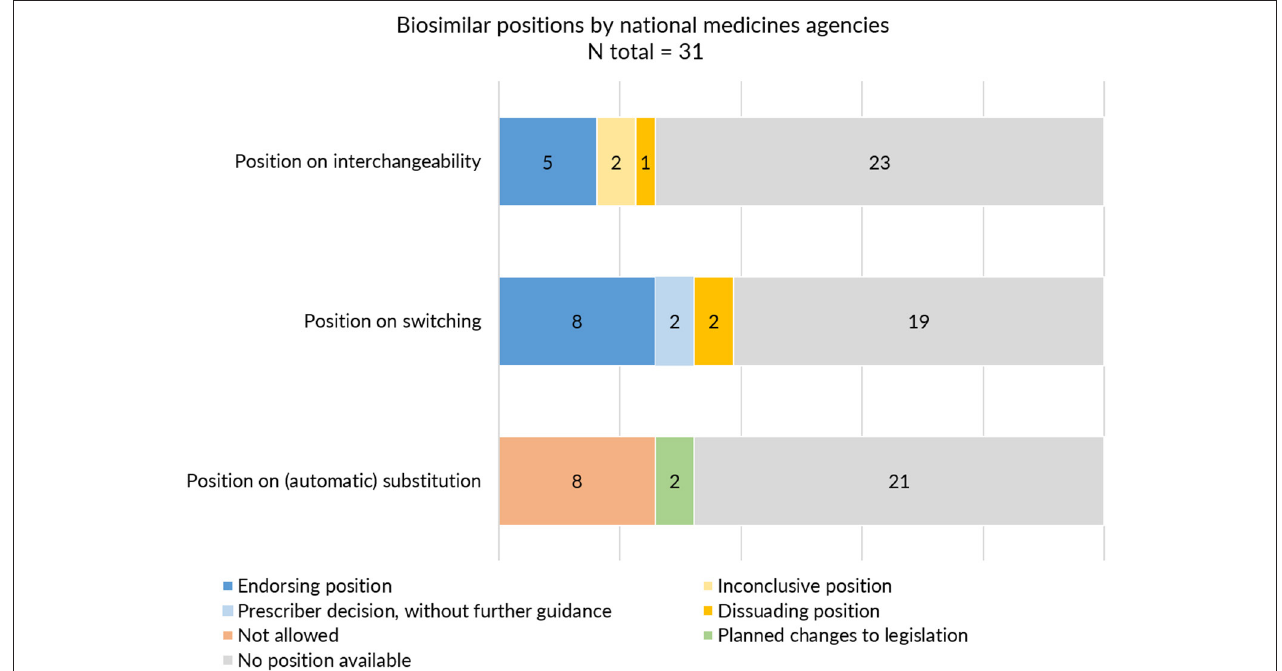
FIGURE 4 | Interchangeability, switching and substitution: type of positions provided by European medicines